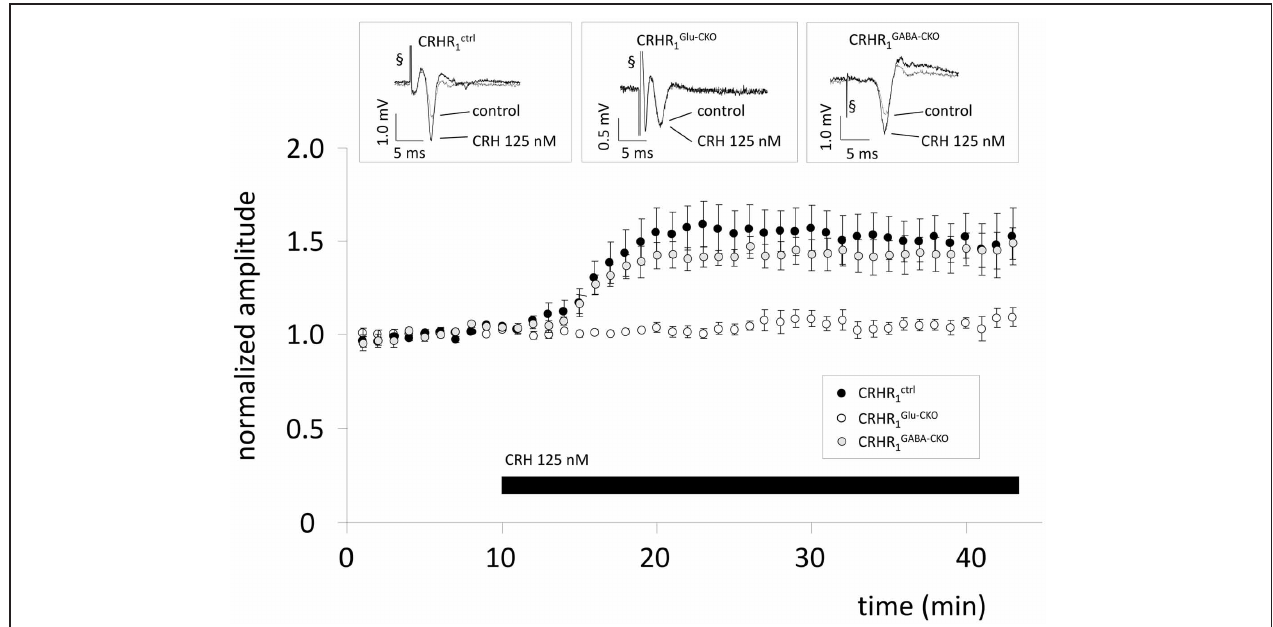
FIGURE 2 | The CRH-mediated effect depends on CRH receptor type 1 (CRHR1) expression on glutamatergic neurons. Slices were prepared from conditional knock-out mice lacking CRHR1 either on glutamatergic neurons (CRHR1 Glu - CKO ) or on GABAergic neurons (CRHR1 GABA - CKO ). CRHR1 flox / flox mice littermates served as control.CRH increases PS amplitude in slices from